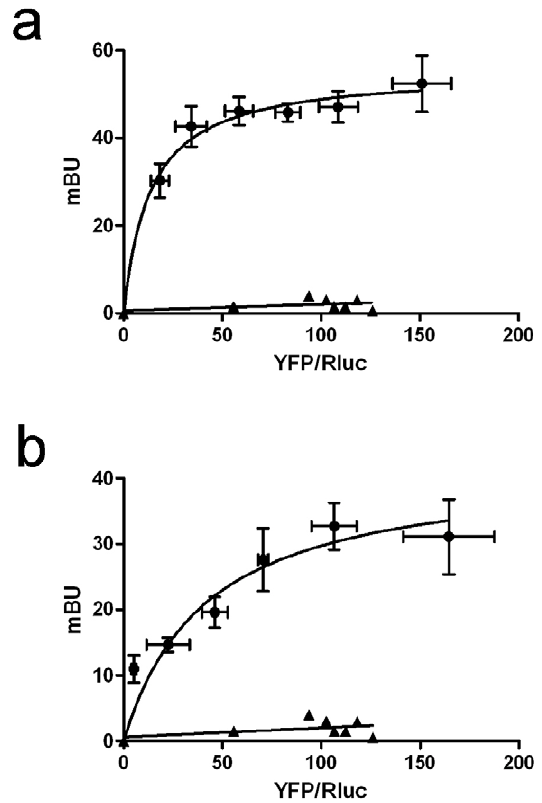
Figure 4. Identification of receptor heteromers in CHO cells by BRET saturation curve. BRET experiments were performed with CHO cells co-expressing A 2A R- RLuc and A 1 R-YFP (A) or A 2A R- RLuc and D 2 R- YFP (B). Co-transfections were performed with increasing amounts of plasmid–YFP (0.25 to 4 m g cDNA corresponding to A 1 R-YFP and 0.5 to 8 m g corresponding to D 2 R-YFP) whereas the A 2A R- RLuc construct was maintained constant (0.5 m g cDNA). Both fluorescence and luminis- cence of each sample were measured before every experiment to confirm similar donor expressions (about 100,000 luminescent units) while monitoring the increase acceptor expression (10,000–25,000 fluorescent units). As a negative control, linear BRET was obtained in cells expressing equivalent luminescence and fluorescence amounts corresponding to A 2A R- RLuc , (0.5 m g transfected cDNA) and serotonin 5HT 2B -YFP (0.5 to 8 m g transfected cDNA) receptors. The relative amount of acceptor is given as the ratio between the fluorescence of the acceptor minus the fluorescence value of cells expressing the donor alone (YFP) and the luciferase activity of the donor (Rluc). BRET data are expressed as means 6 S.D. of 4–6 different experiments grouped as a function of the amount of BRET acceptor.